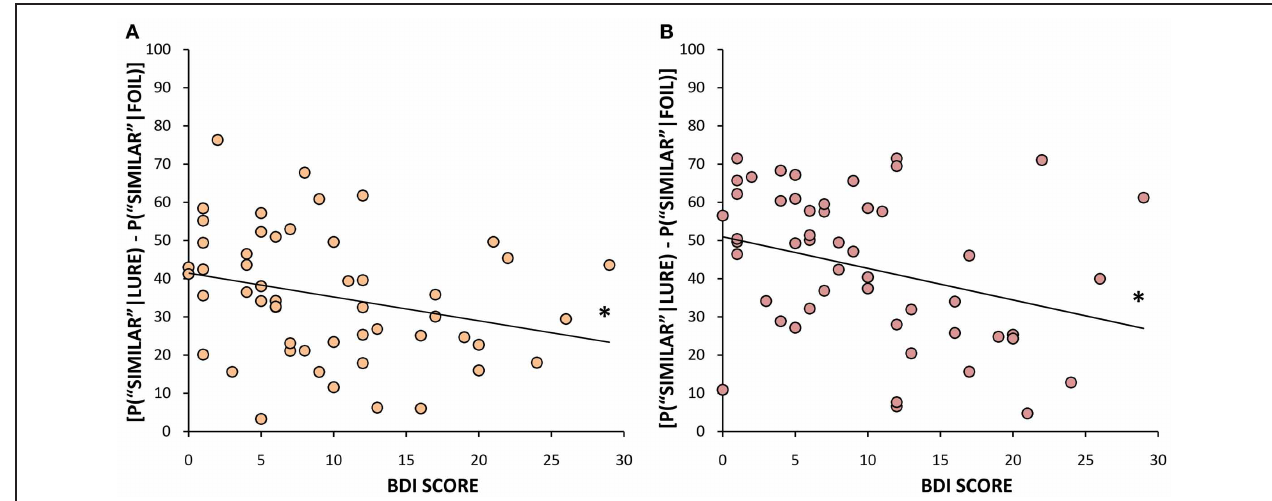
FIGURE 6 | Mean % correct identification of similar lures (bias corrected) as a function of BDI scores, (A) when they appear in the same block as the original target ( r = − 0 . 272, p = 0 . 05), (B) when they are presented in a different block from the original target ( r = − 0 . 297, p = 0 . 03). ∗ p ≤ 0 .